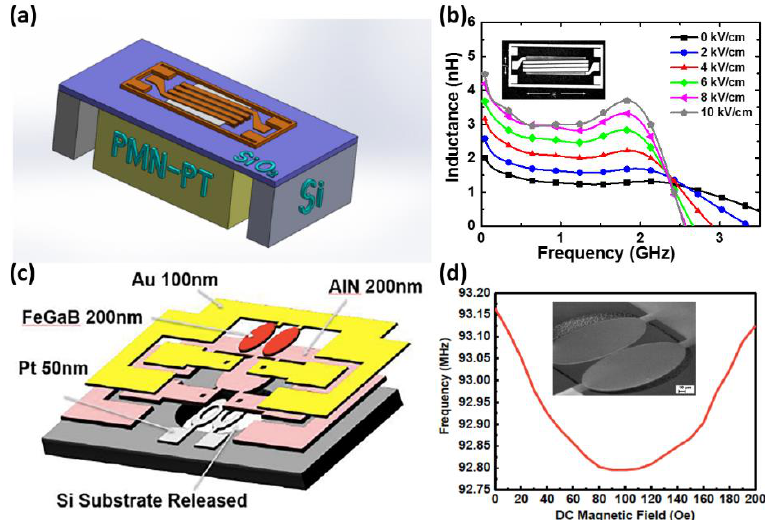
Figure 5. ( a ) Structure model of the voltage tunable inductor based on FeGaB/PMN-PT heterostructures. ( b ) Measured inductance under different E-field applied across the thickness of the PMN-PT slab (inset shows the SEM picture of the inductor). ( c ) Schematic of the voltage tunable filter based on FeGaB/AlN multilayers. ( d ) Dependence of the measured resonant frequency on the applied magnetic field (inset shows the SEM picture of the filter). Reproduced with permission from [32]. Copyright [2016], IEEE.